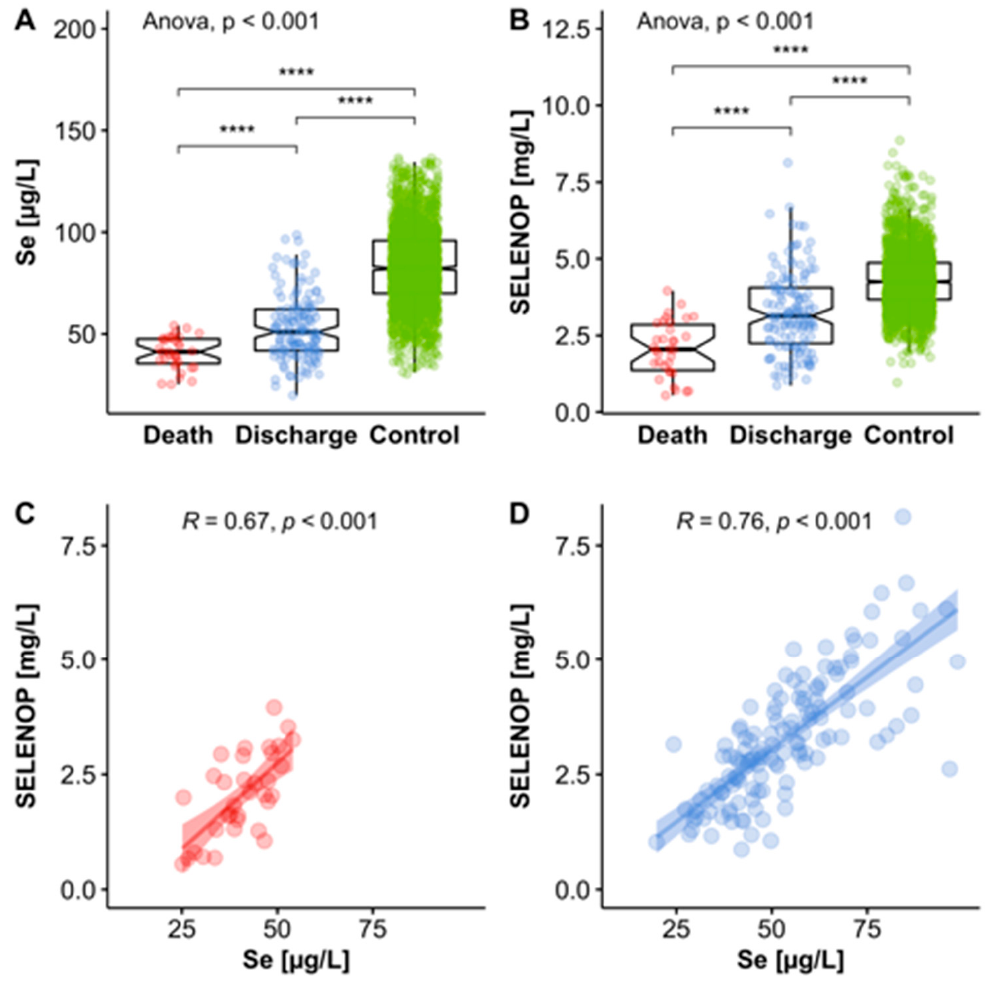
Figure 2. Comparison of Se status in COVID-19 patients who survived or died in relation to healthy controls. ( A ) Total serum Se concentrations differed significantly and were most strongly depressed in COVID-19 patients who did not survive. ( B ) SELENOP concentrations differed to a similar extent and were also lowest in non-survivors. ( C ) As observed in the full cohort of samples, Se and SELENOP showed a strong positive correlation in the group of non-survivors, as well as ( D ) in the group of survivors, albeit across a smaller and more limited concentration range in the non-survivors. All tests were two-sided and p -values < 0.05 were considered statistically significant; R : Spearman correlation coefficient (2-sided, 2-tailed), **** indicates p < 0.0001. A direct comparison of Se status in COVID-19 patients to reference values for the activity of GPx3 as a biomarker was not possible, as GPx3 had not been determined in the samples of the large reference cohort from the EPIC study